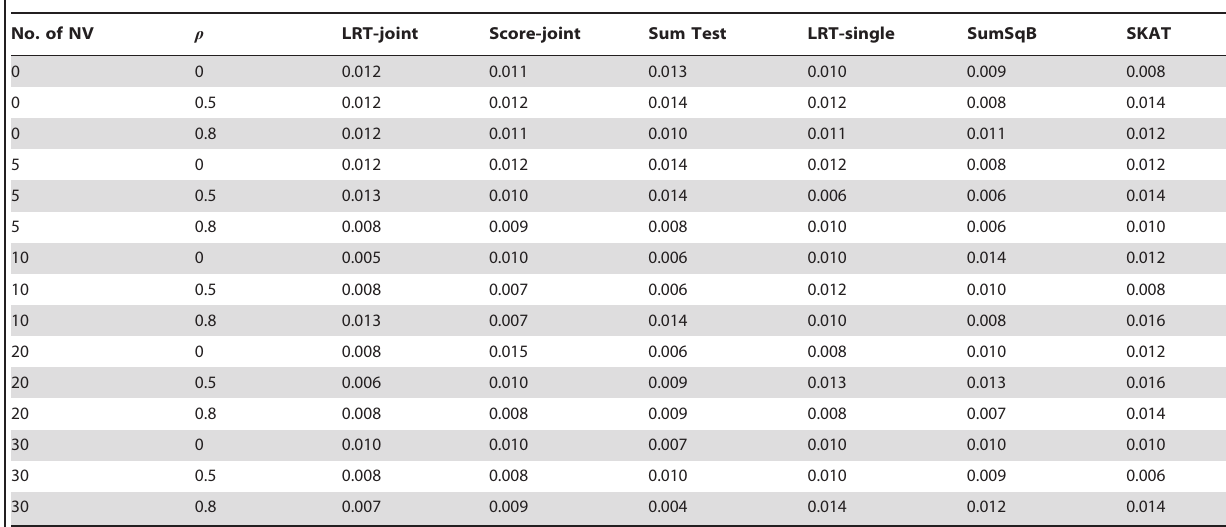
Table 1. Type I error rate for all tests: continuous trait, a ~ 0 : 01 .